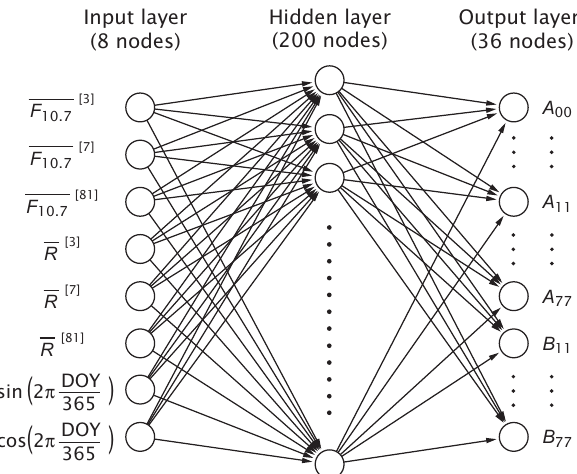
Fig. 4. Schematic diagram of NN. For solar activity indices, [n] denotes an average over n days.